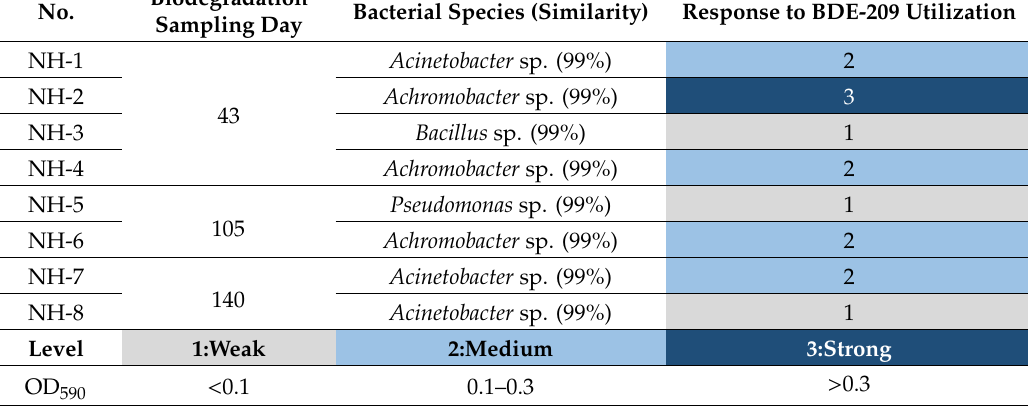
Table 1. Isolated bacterial strains identified during the biodegradation and their ability to utilize BDE-209 as a sole carbon source by the Biolog MT2 microplate